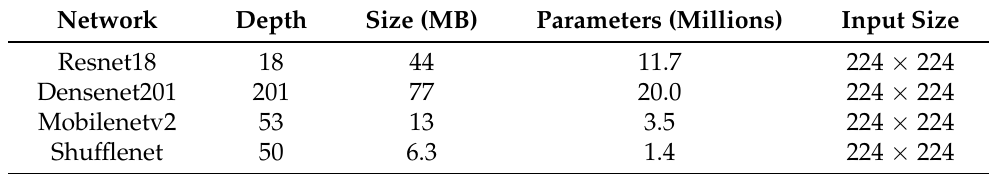
Table 1. Description of the adopted pretrained